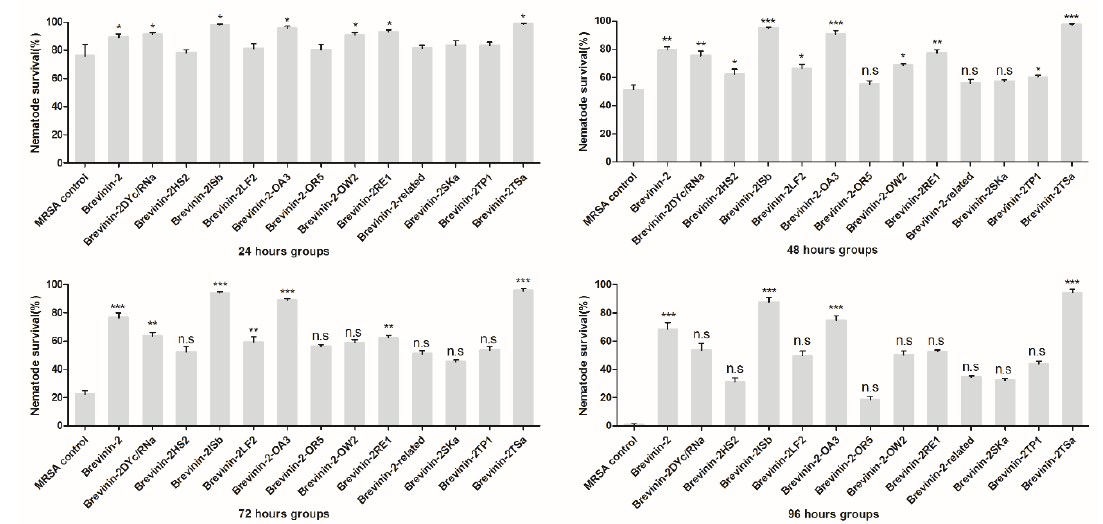
Figure 3. Time-dependent anti-infective screening of Brevinin-2 family peptides. p < 0.05, 0.01, and 0.001 indicates a significant difference compared with control groups and is labeled with *,**, and ***. If test group rate was below 60%, it was labeled with “n.s”.